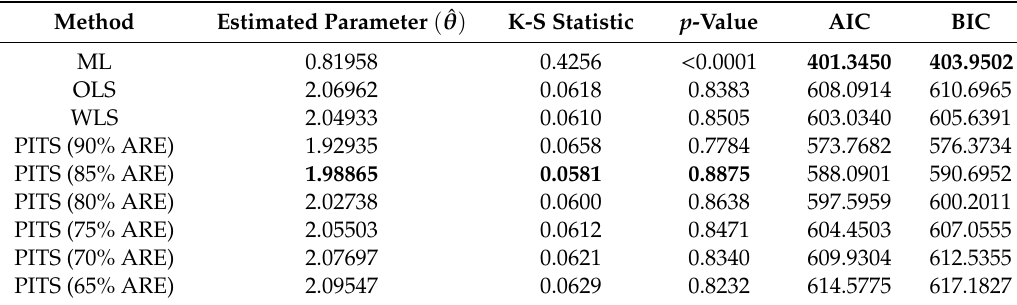
Table 11. Parameter estimates and goodness of fits of Lindley distribution for simulated data from Lindley distribution with θ = 2, n = 100 and 5%